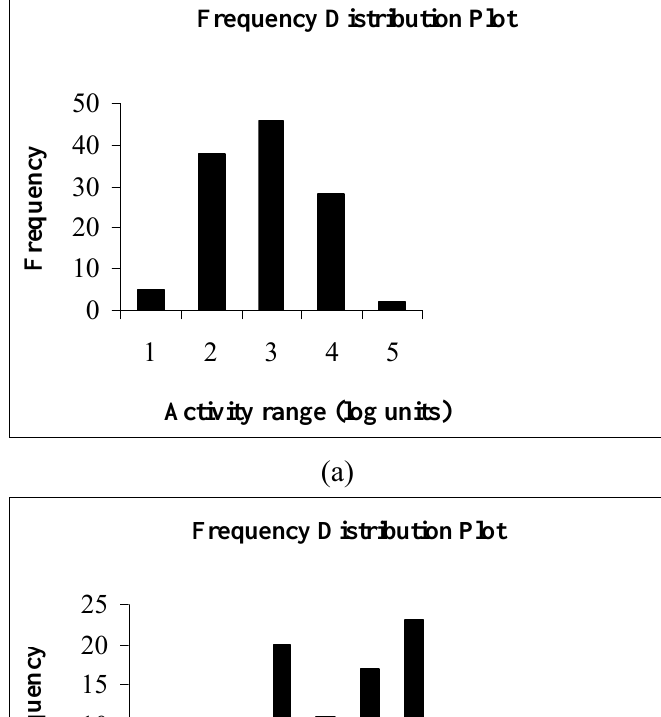
Figure 13. Frequency distribution of compounds for different relative ranges of biological activity data (from low to high in log units): (a) data set I, (b) data set II, (c) data set III. Frequency Distribution